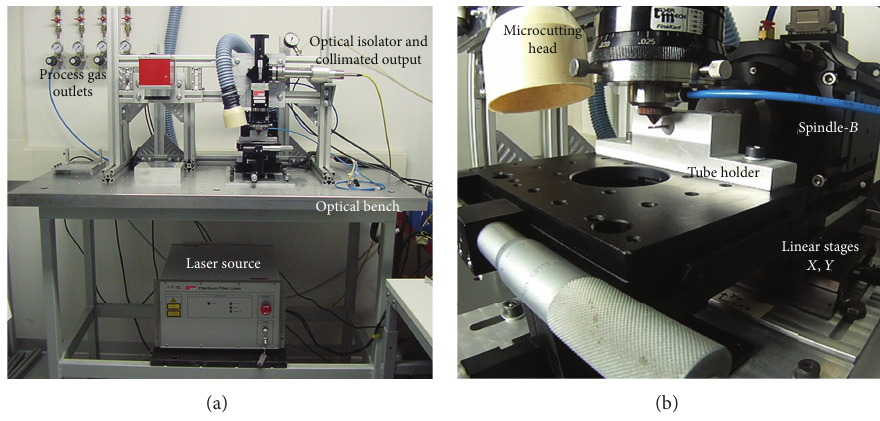
Figure 1: Laser microcutting setup used for the laser microcutting of AZ31